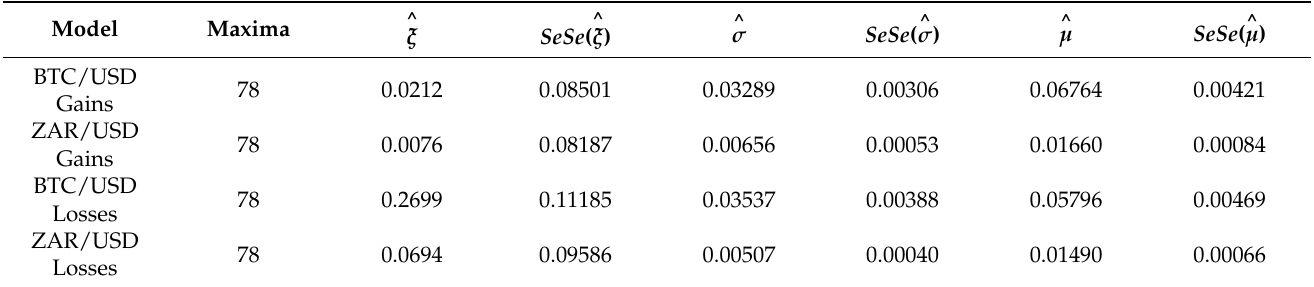
Table 2. Parameter estimates using maximum likelihood estimator for GEVD.